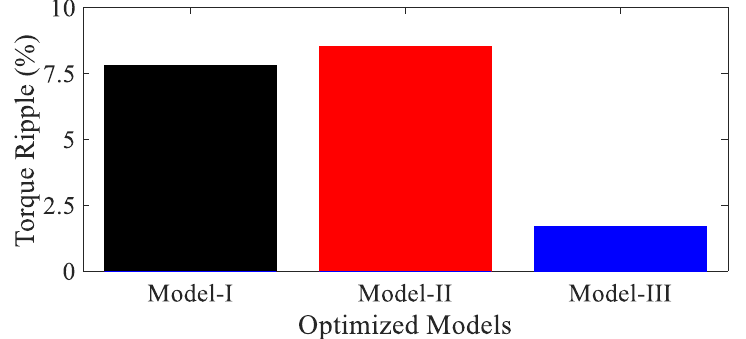
Figure 18. Torque ripple of the optimized models.